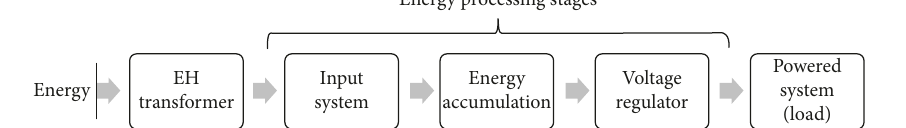
Figure 1: Topology of an exemplary power electronics solution (reproduced from Michalski et al. [4], under the Creative Commons Attribution License/public